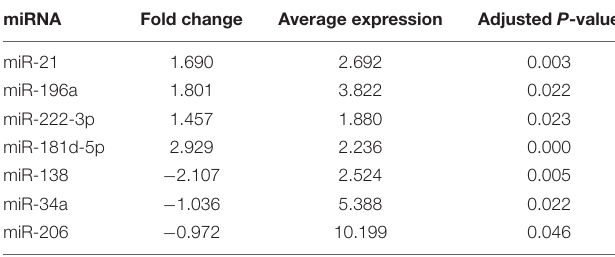
TABLE 5 | Results of miR microarray